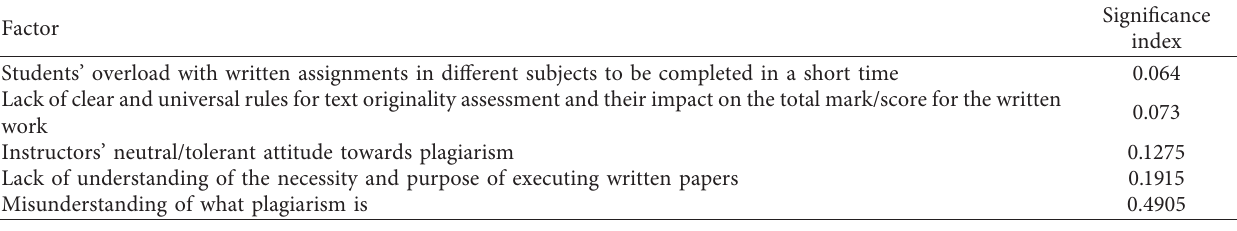
Table 6: Significance index for factors contributing to violations of scientific and academic integrity